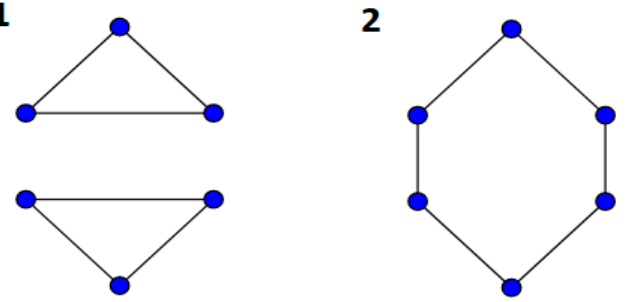
Figure 1 . Number (1) does not have a Hamiltonian circuit, and number (2) has a Hamiltonian cir-